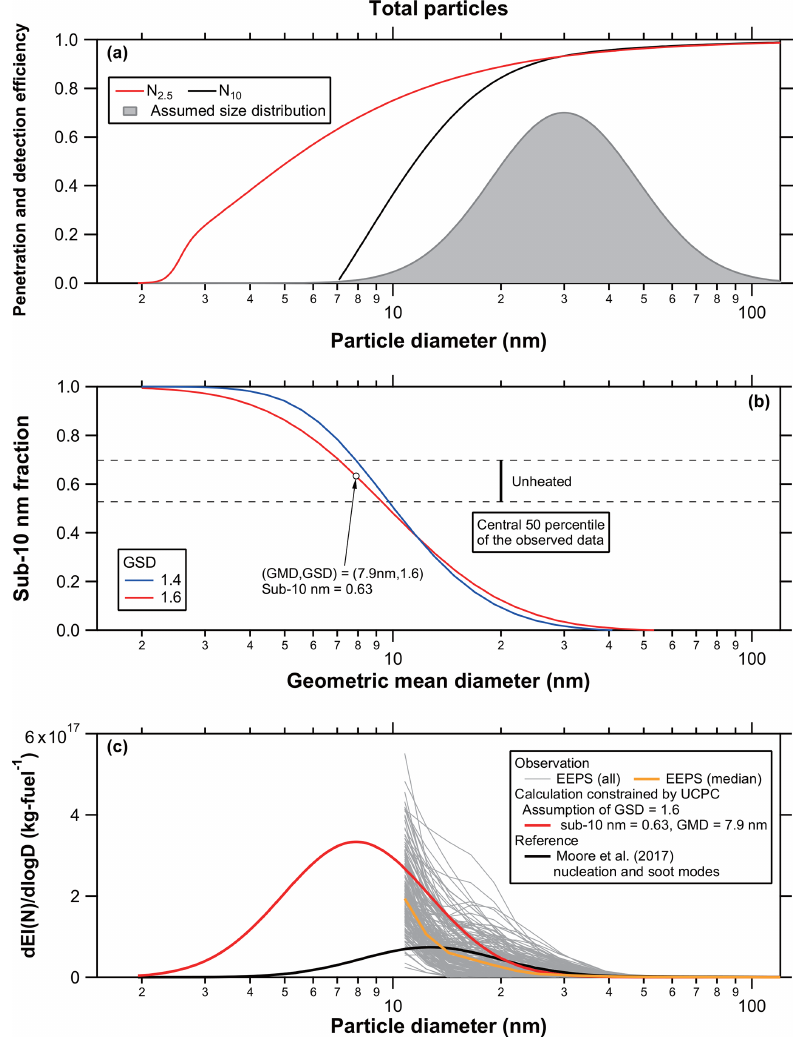
Figure 9. (a) Overall penetration and detection efficiencies for the unheated N 2 . 5 and N 10 . The shaded area represents an example of the assumed particle number size distributions for calculating the number fraction of sub-10nm particles. (b) Number fraction of sub-10nm particles (1 − (cid:49)N 10 /(cid:49)N 2 . 5 ) obtained by convolution of the penetration and detection efficiency curves in (a) and assumed particle number size distributions having various GMDs and GSDs. The horizontal dashed lines indicate the central 50th percentile range (between 25th and 75th percentiles) of the observed data for the unheated mode. (c) Example of the particle number EI size distributions that explains the observed medians of the (cid:49)N 10 /(cid:49)N 2 . 5 ratios and EI( N 2 . 5 ) for the unheated mode (red). The number EI size distributions with (GMD, GSD) = (12.7nm, 1.56) and (61nm, 1.48), which correspond to the average nucleation and soot mode distributions (black) reported